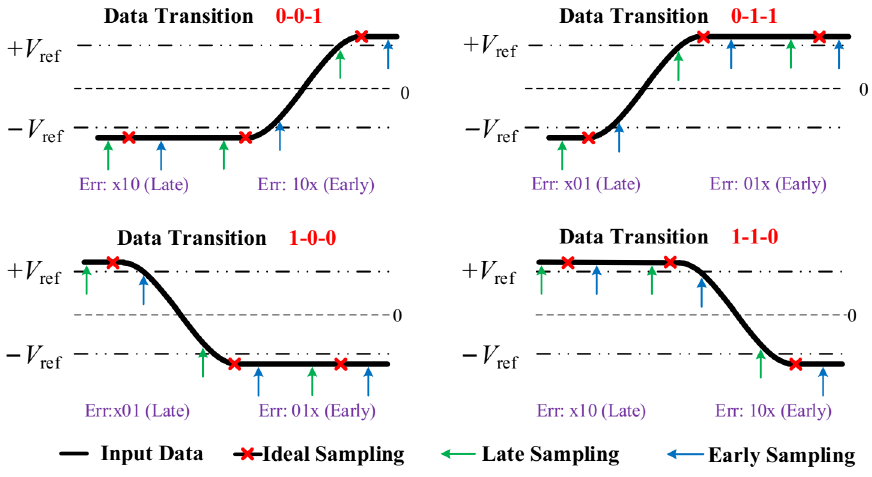
Figure 2. MMPD phase detection waveform.